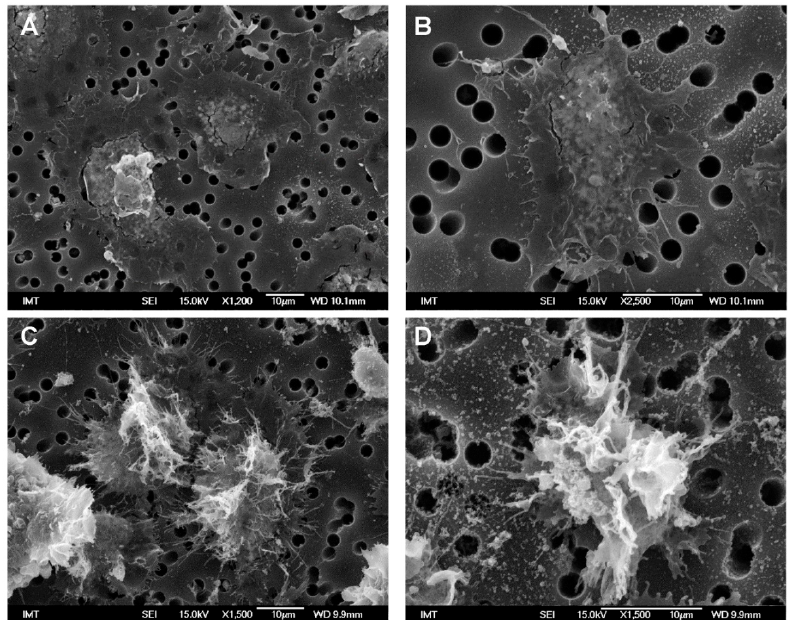
Figure 1. Scanning electron microscopy (SEM) images of control hemocytes from M. galloprovincialis in different media. ( A , B ) in artificial seawater (ASW); ( C , D ) in hemolymph serum (HS). Hemocytes were attached to a paper filter support with pore size of 3 µ